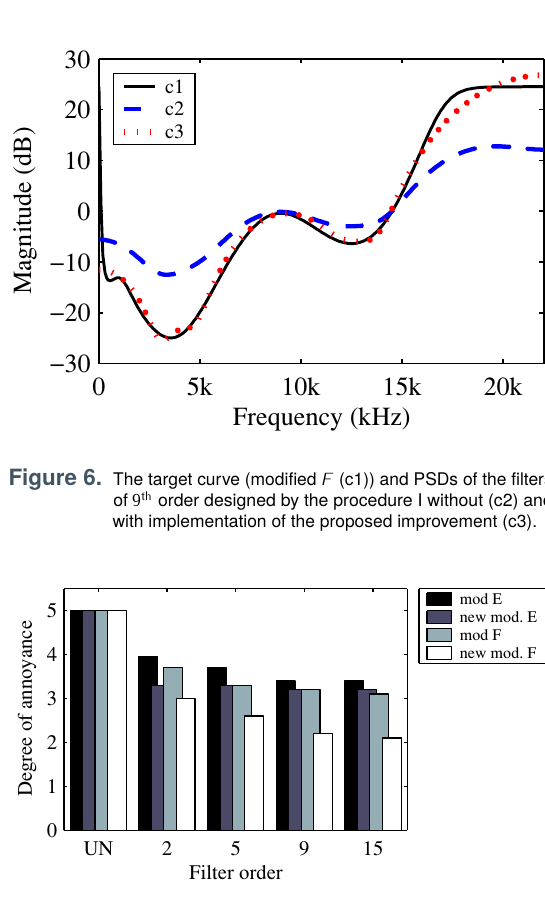
Figure 7. Theaveragedresultsofthelisteningtestsforall 25 subjects: the degree of annoyance of noise shaped by the filters of order 2 , 5 , 9 and 15 designed by the procedure I using the indicated design curves (modified E , new modified E , modified F and new modified F ) relative to the annoyance of unshaped noise